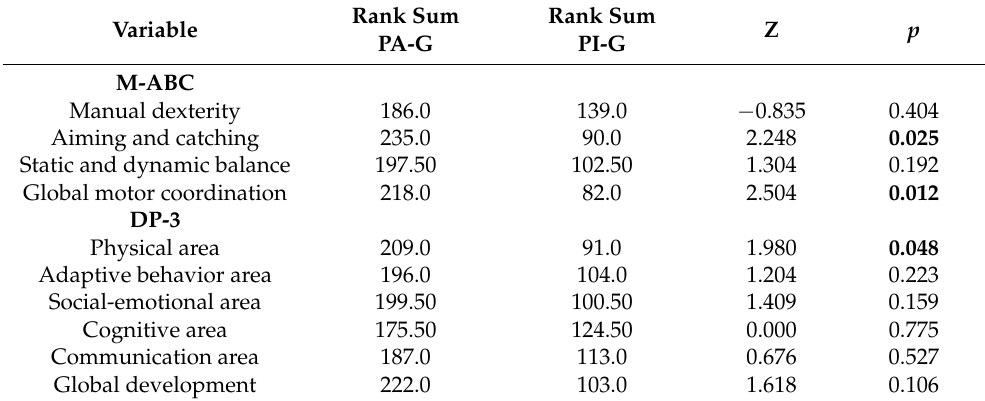
Table 4. Comparisons between the PA-G and the PI-G through Mann–Whitney U Test.